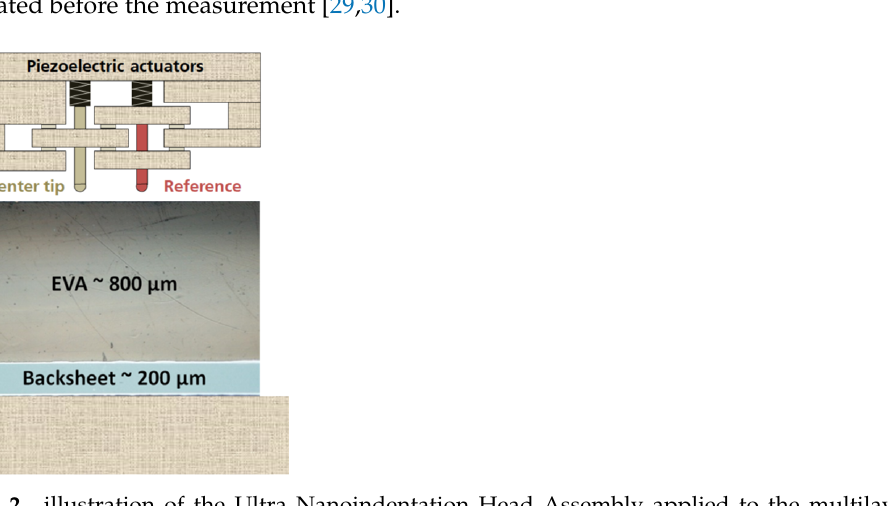
Figure 2. illustration of the Ultra Nanoindentation Head Assembly applied to the multilayer EVA-BS